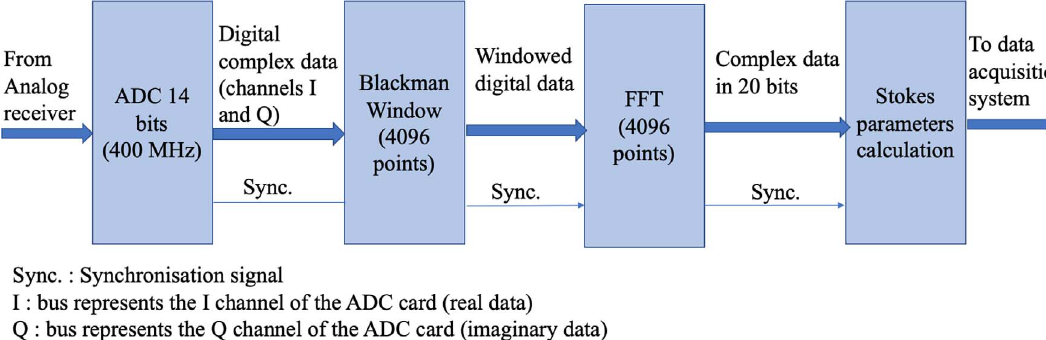
Fig. 3. Block diagram of the ORFEES digital receiver.